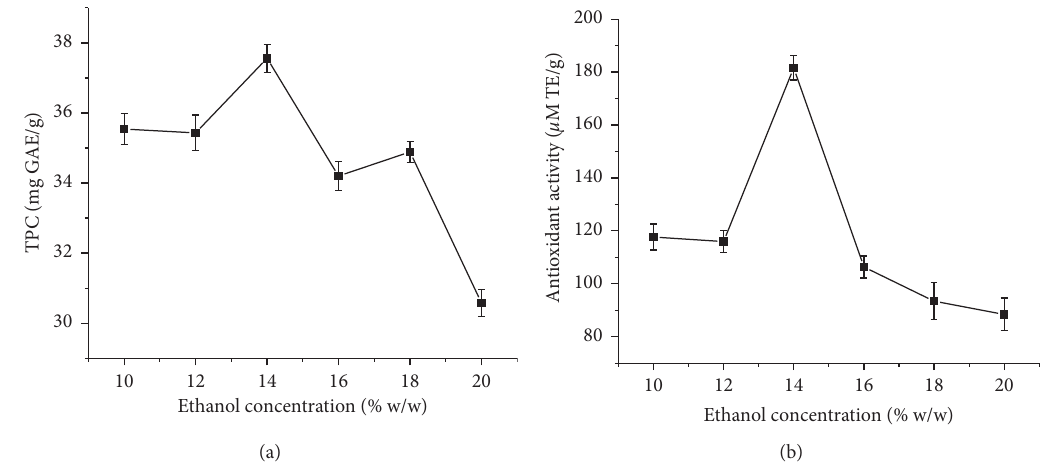
Figure 1: Effect of ethanol concentration (% w/w) on the (a) TPC (mg GAE/g) and (b) antioxidant activity ( μ M TE/g) of the extract.